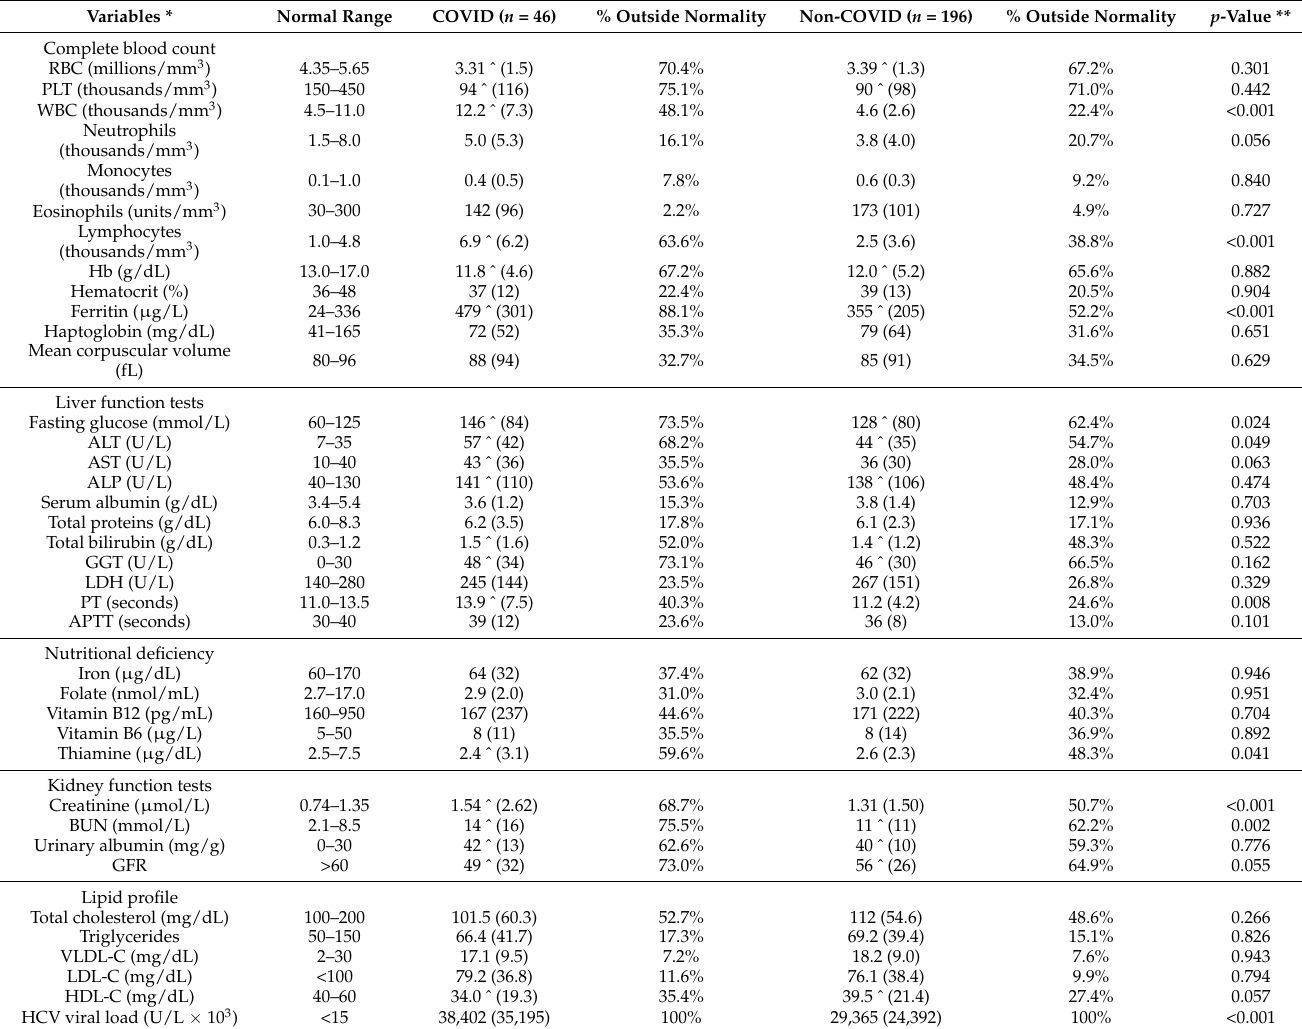
Table 2. Comparison of serum parameters between COVID-19 and non-COVID-19 patients with